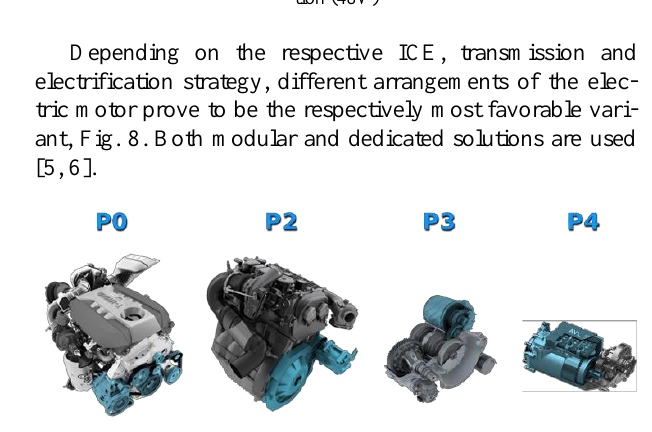
Fig. 7. Interaction of ICE, Automated Transmission and Mild Hybridiza- tion (48V)